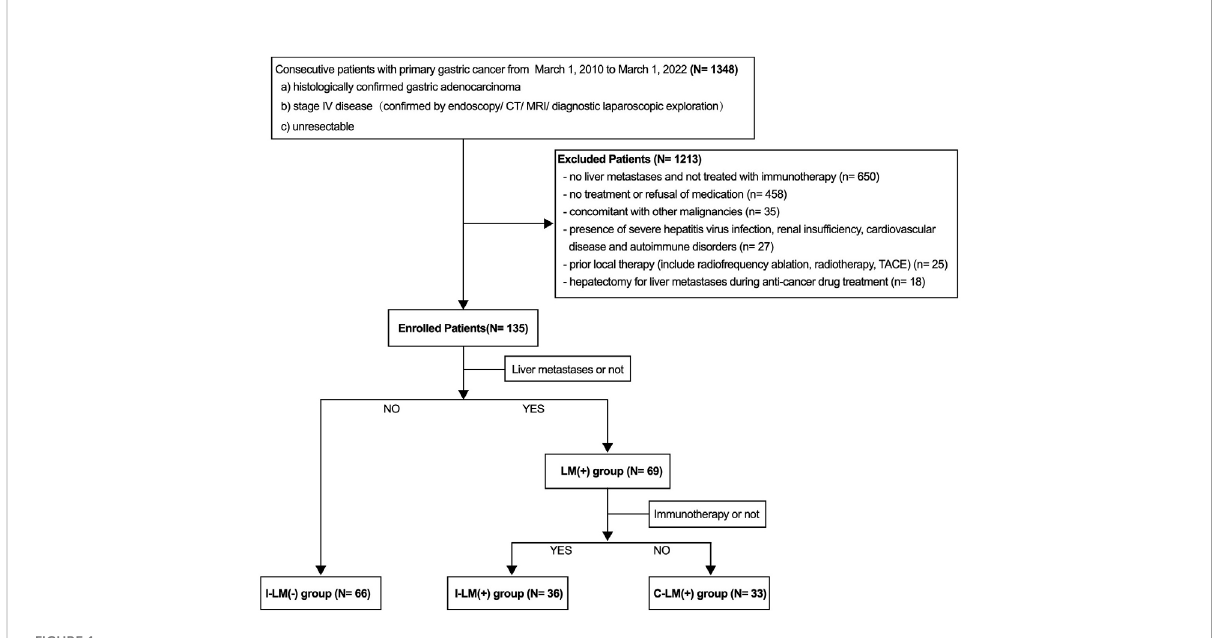
FIGURE 1 Flowchart of the study